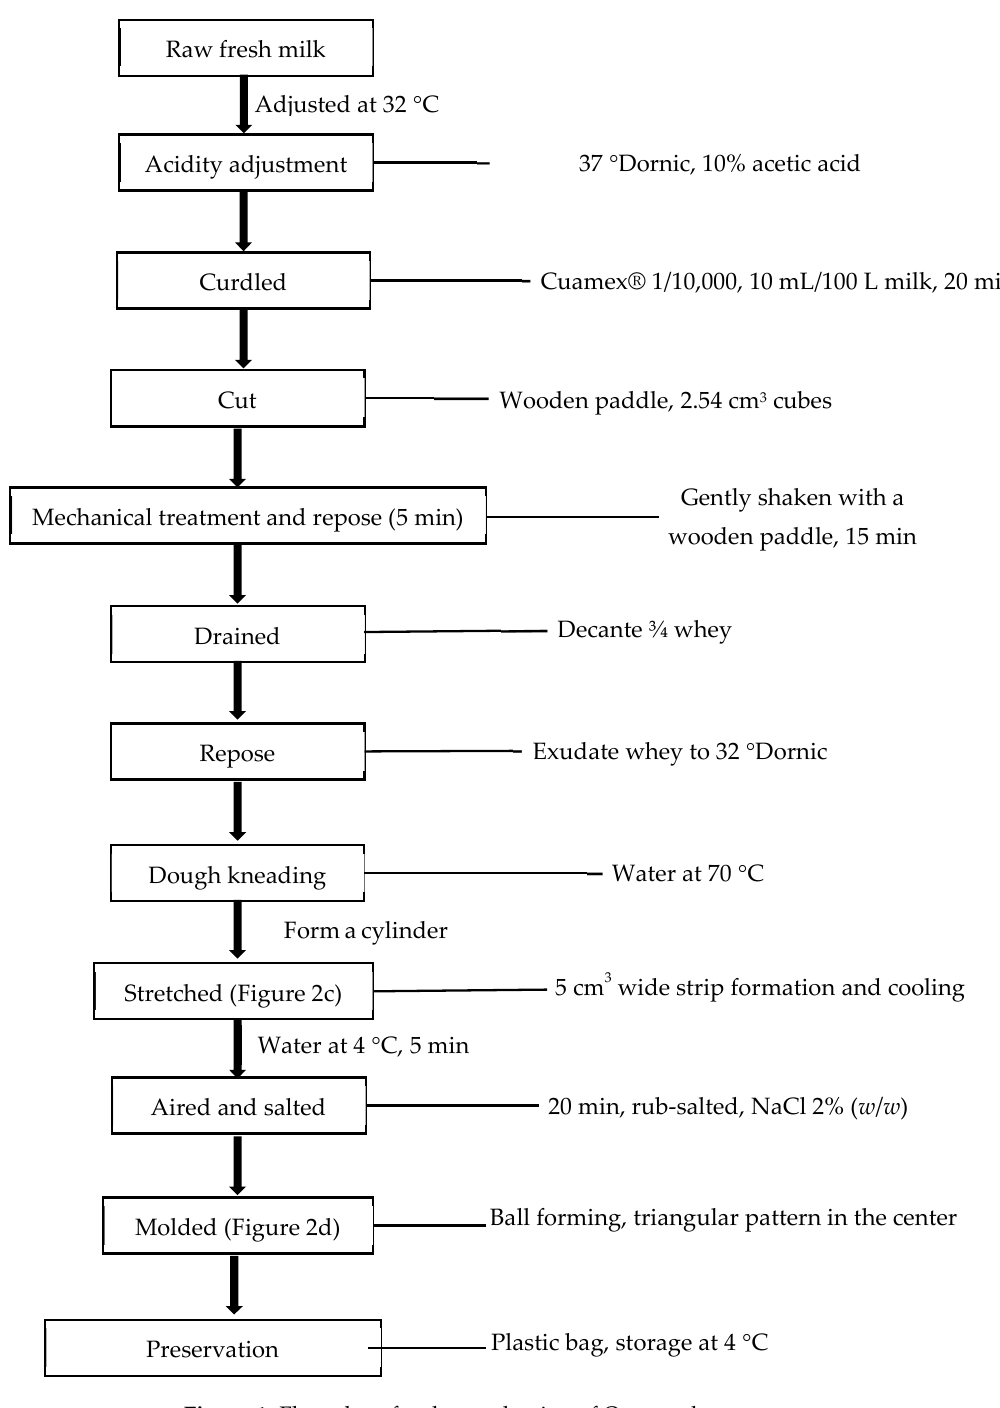
Figure 1. Flow chart for the production of Oaxaca cheese.